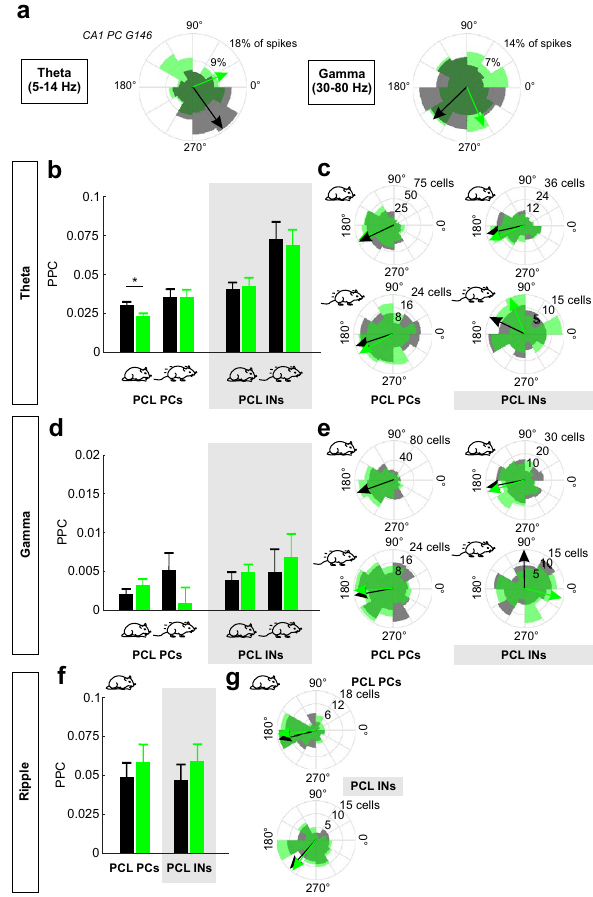
Figure 3. Optogenetic silencing of PVIs disrupts spike-phase coupling of CA1 PCs. ( a ) Polar phase histograms of an example CA1 PC showing significant spike-phase coupling with theta (left) and gamma (right) oscillations during control conditions (grey areas). During light illumination significant spike-phase coupling is lost (green areas). Arrows indicate preferred oscillatory phase of firing. Length of the arrows is adjusted to the maximum of the respective polar phase histograms. ( b ) Strength of spike-theta phase coupling of CA1 PCs (left) and PCL INs (right, grey box) quantified by the pairwise phase consistency (PPC) during light on (black) and light off (green) periods. Resting and running periods were analyzed separately (schematic mice below). ( c ) Polar histograms depicting the distribution of preferred theta oscillation phases for the following conditions: CA1 PCs, resting mice (top left); PCs, running mice (bottom left); PCL INs, resting (top right); INs, running (bottom right). Grey areas summarize light off -, green areas light on periods. Black/green arrows indicate average oscillation phase of spiking. Light-mediated PVI silencing did not affect the average oscillation phases of spiking. ( d ) and ( e ) In analogy to ( b ) and ( c ), analysis of spike-gamma phase coupling of CA1 PCs and PCL INs with respect to the strength ( d ) and the preferred gamma phase of spiking ( e ) in resting and running mice. ( f ) , ( g ) Analogous to ( b ) and ( c ), analysis of spike-ripple phase coupling of CA1 PCs and PCL INs regarding the strength of spike-ripple phase coupling ( f ) and preferred ripple phase of spiking ( g ) only for resting episodes. PCL, pyramidal cell layer. * p <